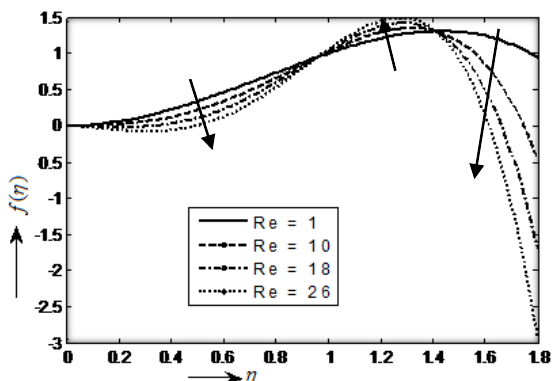
Figure 16. The graph of fluid velocity f (  ) against  for Reynolds numbers Re (1, 10, 18, 26) by taking M =0, K = 0 and  =